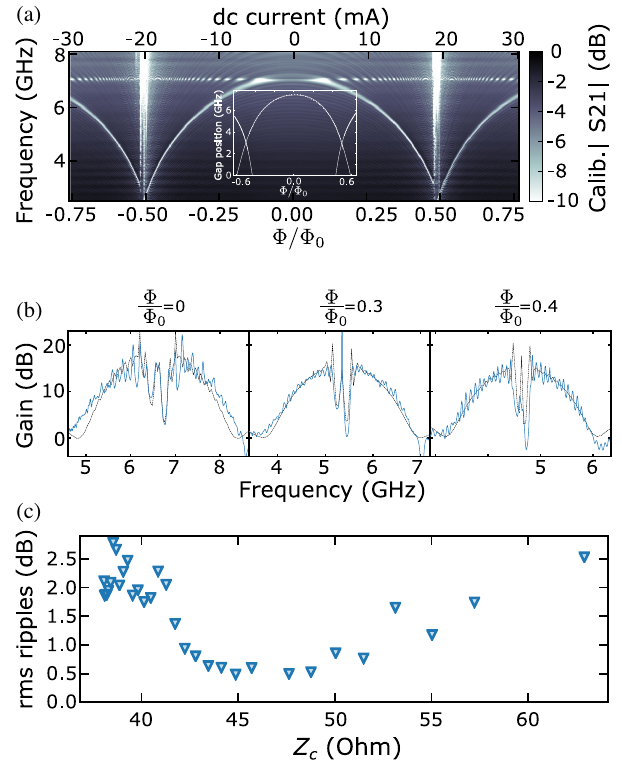
FIG. 5. (a) Calibrated transmission versus flux and probe frequency. Inset: interpolation of the gap position down to zero frequency. The distance between two intercrossing domains at zero frequency gives information about the SQUID stray induct- ance. (b) Three gain profiles of device B for three different flux points. Gain ripples evolve with flux bias. (c) Root-mean-square values of gain ripples for 25 different flux biases. Each of this flux is converted to a characteristic impedance minimum is found for a small-signal impedance equal to 48 Ω